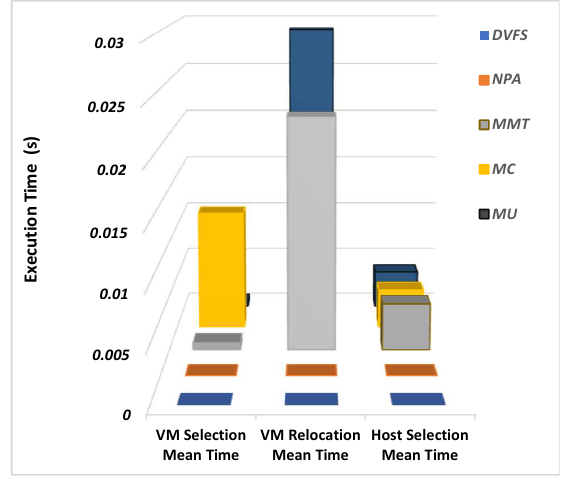
Figure 6. Virtual Machine Performance Time for Every Host.